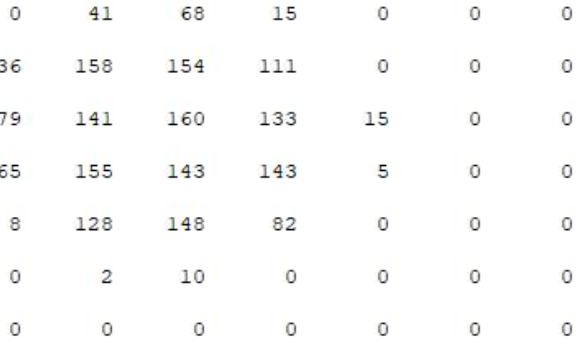
Figure 3. Data distribution of partition function p = 7.